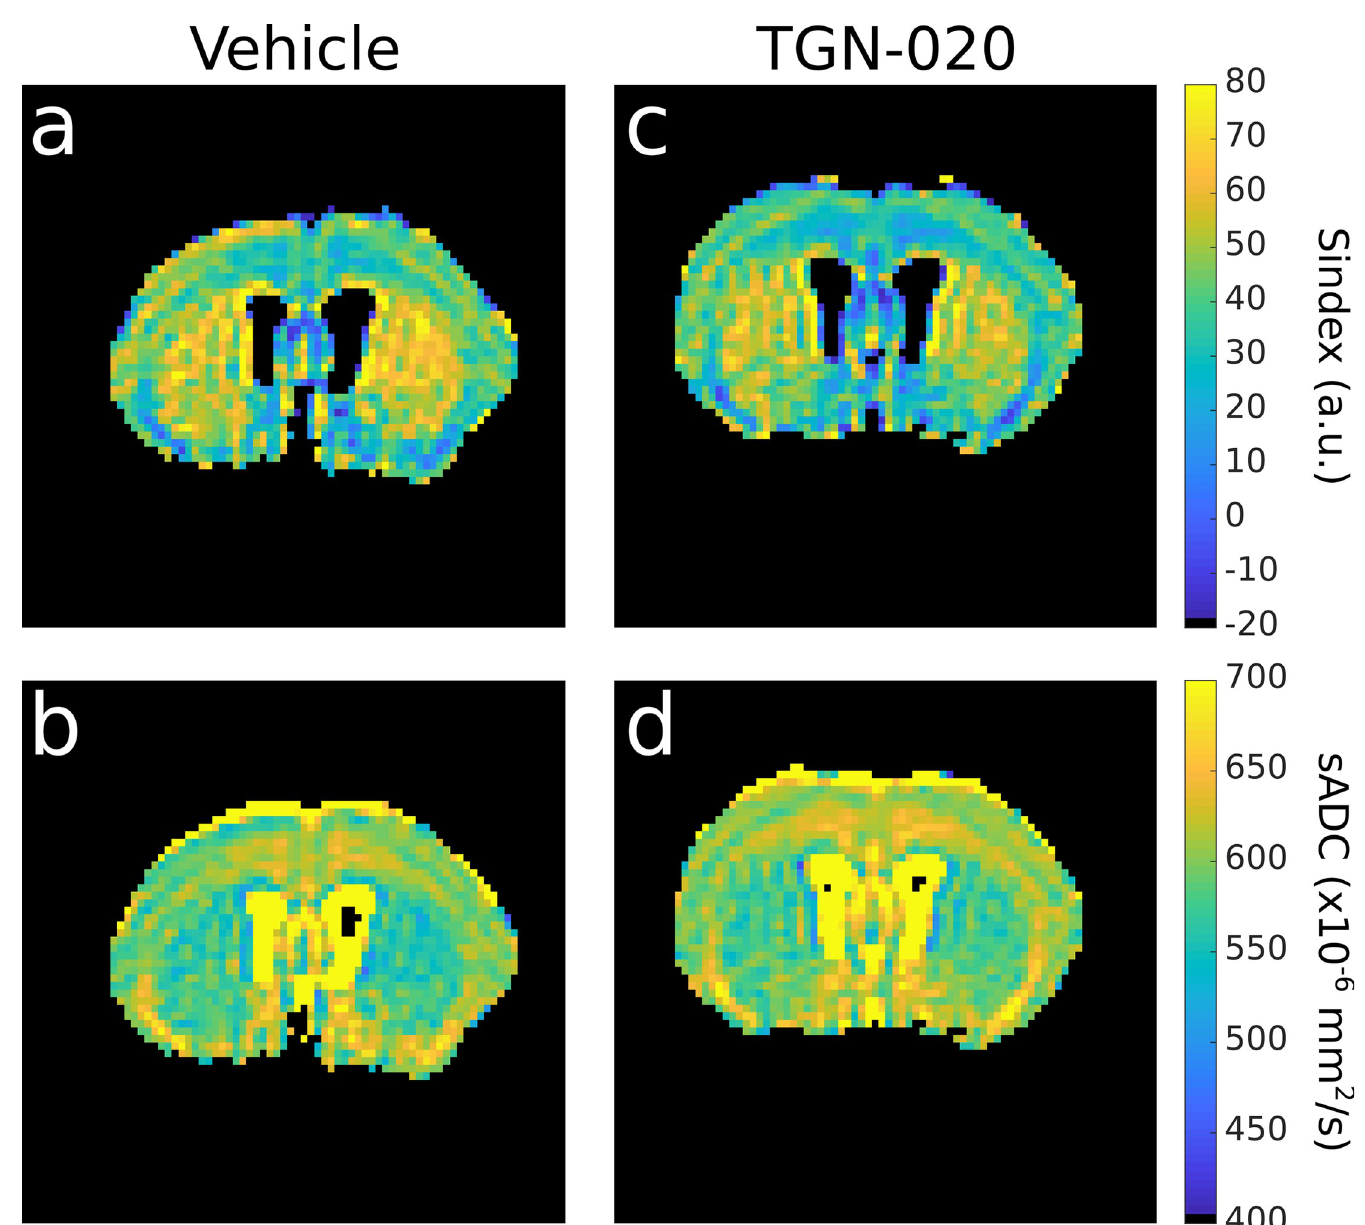
Fig 3. Sindex (first row) maps and sADC (second row) maps for a representative mouse from vehicle group (first column) and from TGN-020 group (right column). These maps were obtained by averaging the 6 last time points. https://doi.org/10.1371/journal.pone.0229702.g003 Sindex, in vehicle and TGN-020 group. TGN-020 injection resulted in significant increase in sADC in the cortex (p = 0.0064) and the hippocampus (p = 0.00068) but not in the striatum (p = 0.26). No significant change of sADC was observed following vehicle injection in any of the ROIs considered (p = 0.91 in cortex, 0.78 in hippocampus and 0.14 in striatum). We also investigated subregions of the hippocampus CA3 and DG (S1 Fig). The TGN-020 injection sig- nificantly decreased Sindex and increased sADC values both in the DG and the CA3 (Sindex in DG: -11.8, p = 4.8e-7 and in CA3: -4.8, p = 0.00012; sADC in CA3: +10.2, p = 0.00013,